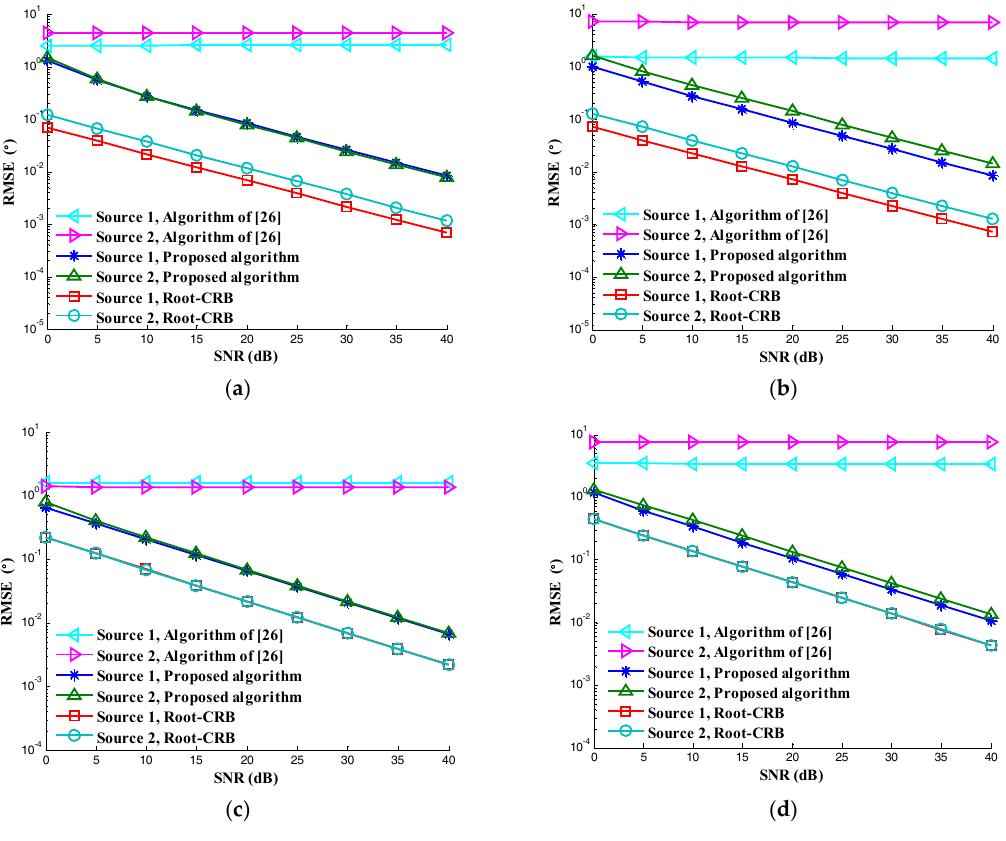
Figure 6. RMSE versus SNR: ( a ) Elevation; ( b ) Azimuth; ( c ) Auxiliary polarization angle; ( d ) Polarization phase difference.